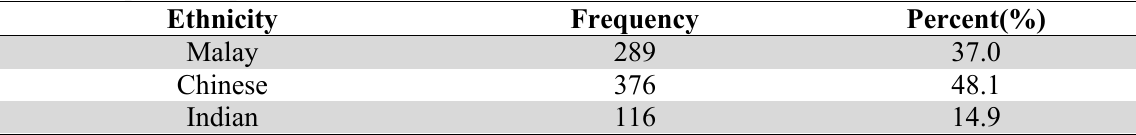
Ethnic Groups of Respondents